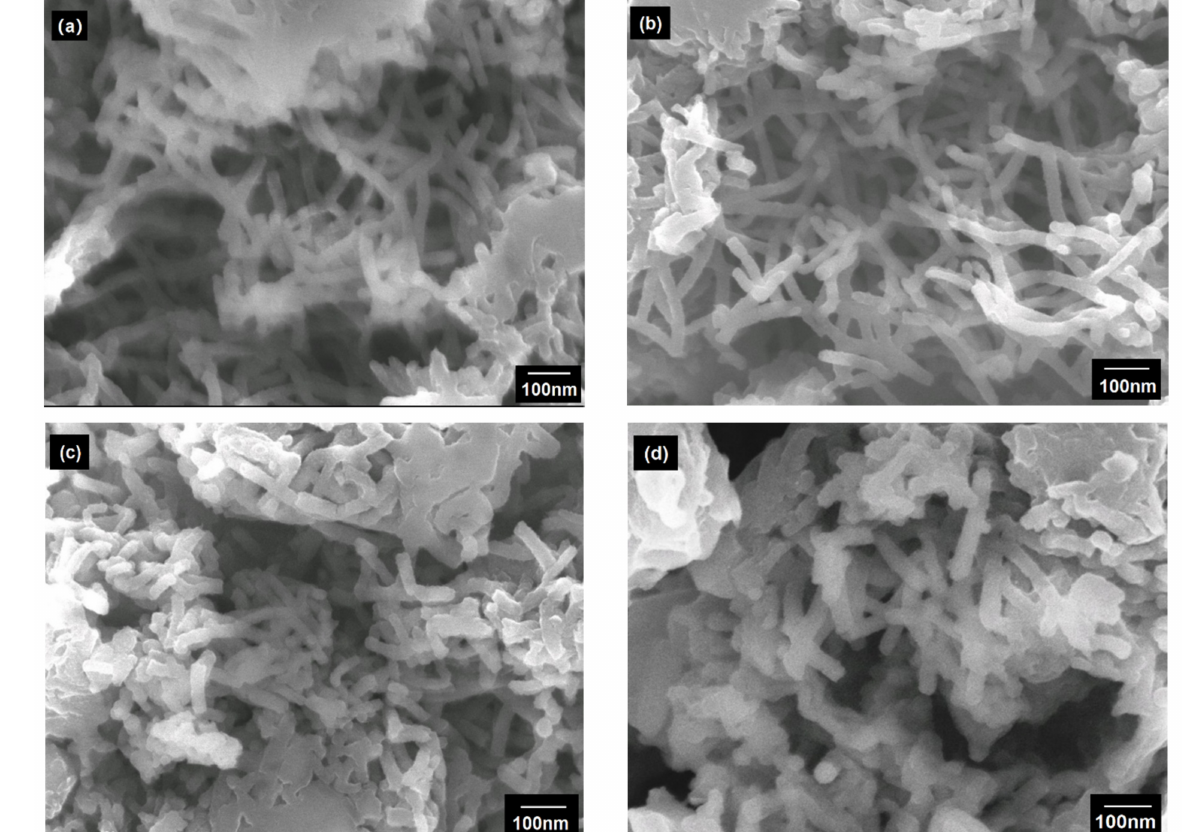
Figure 5. ( a ) Scanning electron microscope of poly (AN–Ag) composite/2:1 wt (AN: Ag); ( b ) scanning electron microscope of poly (AN–Ag) composite/4:1 wt (AN: Ag); ( c ) scanning electron microscope of poly (AN–Ag) composite/8:1 wt (AN: Ag); ( d ) scanning electron microscope of poly (AN–Ag–S)